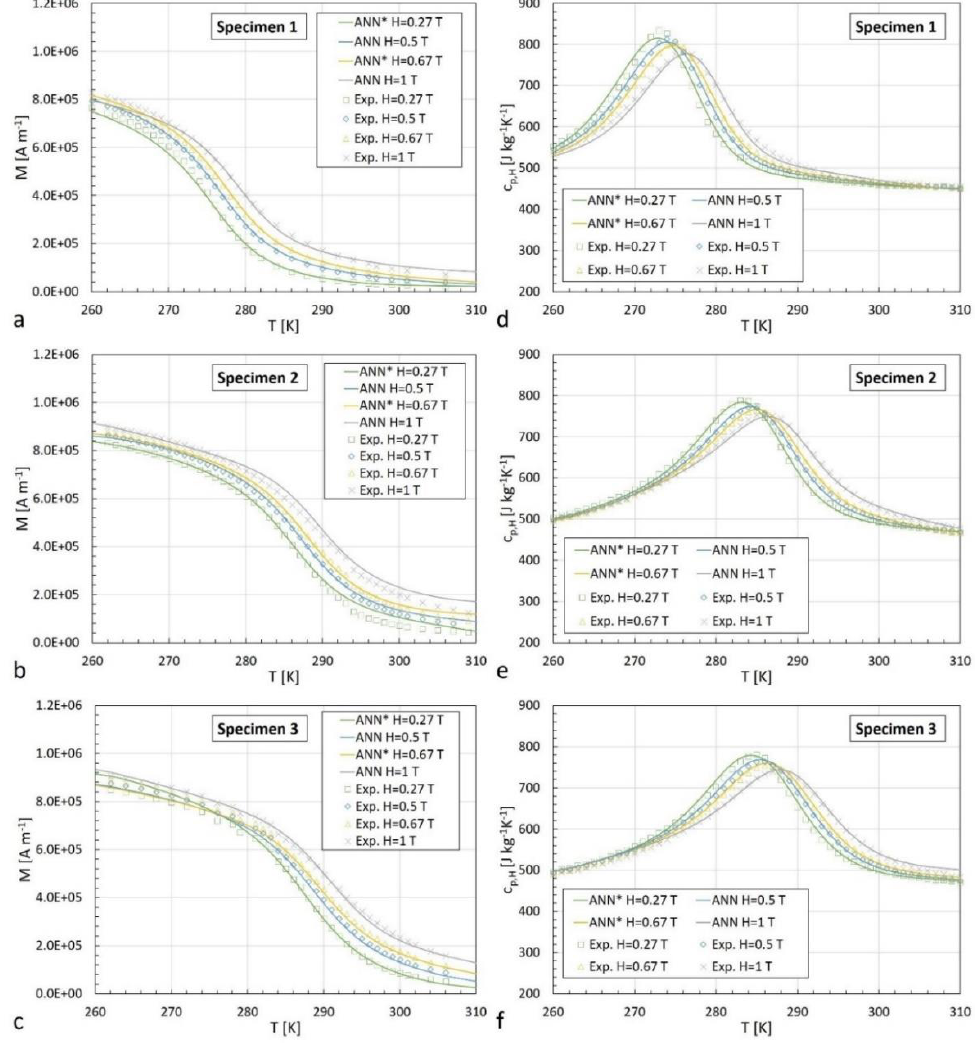
Figure 7. Measured and predicted values at different magnetic fields: ( a – c ) Magnetization of the three samples of La-Fe-Co-Si alloy, ( d – f ) Specific heat at a constant magnetic field of the three samples of La-Fe-Co-Si alloy. The asterisk in the legend indicates an applied magnetic field not included in the training dataset.